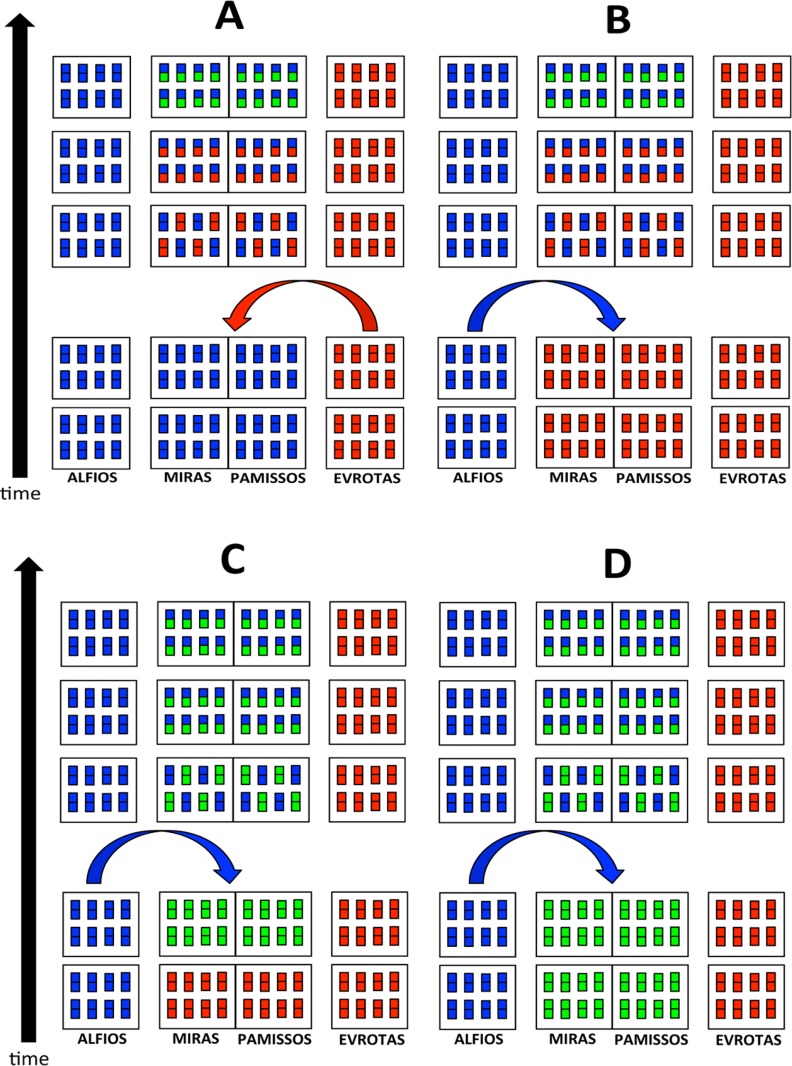
Hypothetical biogeographical scenarios explaining the mitochondrial capture event from Squalius keadicus to Squalius peloponensis.Each rectangle symbolizes a hypothetical individual within the analysed population. The two squares within each rectangle symbolize the mitochondrial and the nuclear genome of this hypothetical individual in the population. Colours indicate populations: Blue = S. peloponensis lineage; Red = S. keadicus lineage; Green = S. keadicus-like mitochondrial lineage (Miras and Pamissos populations).